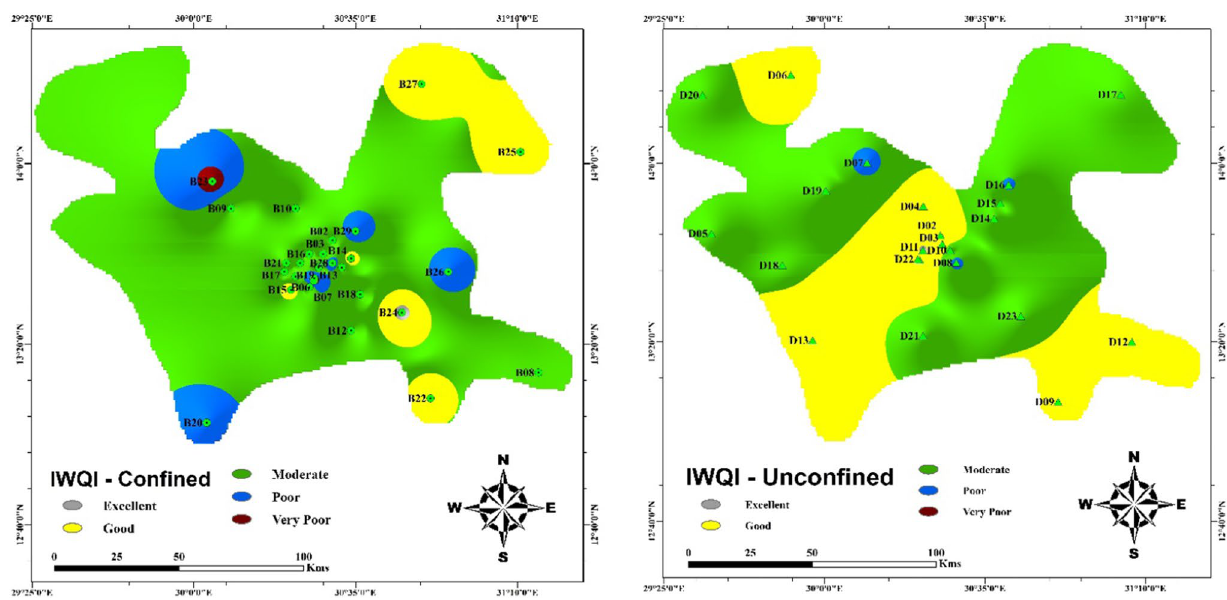
Fig. 10 Spatial distribution of GIS interpolation maps of the IWQI in the confined and unconfined